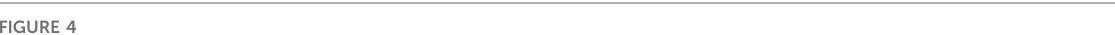
FIGURE 4 perifused with medium containing 0 (G0) or 20 mmol/L glucose (G20). Forskolin (1 μ mol/L, FK), gliclazide (25 μ mol/L, GCZ), diazoxide (250 μ mol/L, DZ)andKCl(30 mmol/L,K30)wereadded.Secretionfromeachgraftwasnormalizedtothemaximumsecretionduringthe fi rst12-mininK30-Dz.N, number of independent experiments, de fi ned as one iPSC-beta cell differentiation or one human or mouse islet preparation or one humanized mouse, as indicated. ** p < 0.01, *** p < 0.001 vs basal condition (time 0-min) using mixed-effects analysis followed by Dunnett ’ s (b) or Sidak ’ s (e) correction for multiple